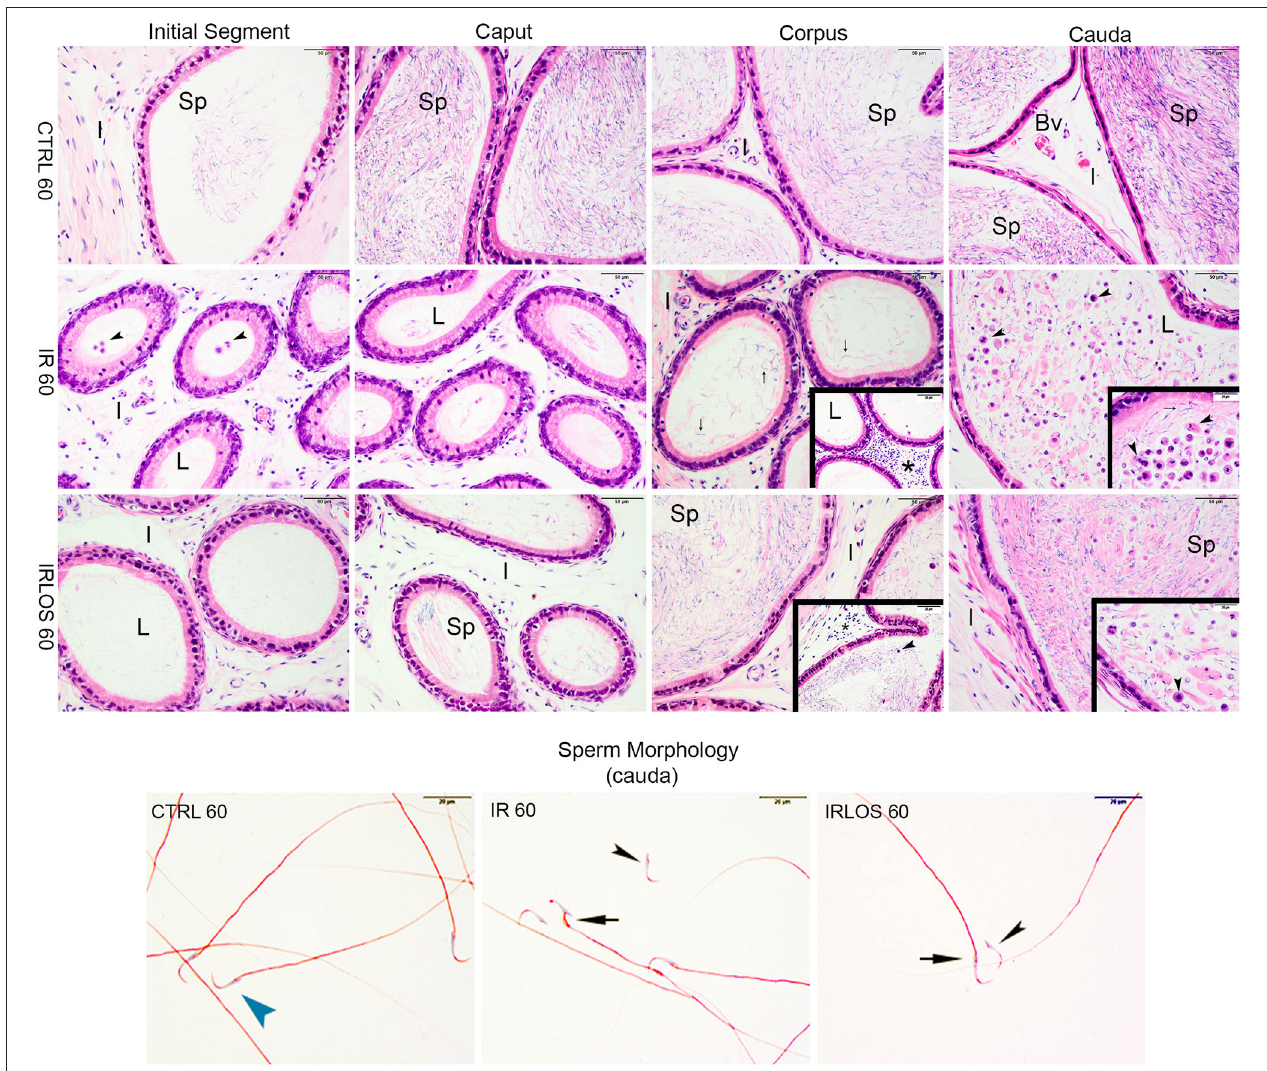
FIGURE 4 | Representative photomicrographs of epididymis and sperm morphology from control (CTRL 60), irradiated (IR 60), and irradiated and treated with losartan (IRLOS 60) groups after 60 days of exposure to the ionizing radiation. In the control group, the epididymis segments (initial segment, caput, corpus, and cauda) exhibited a normal morphology, with high intraluminal (L) sperm (sp) content. The irradiated group exhibits damage signal irradiation, characterized by a decrease of sperm content and extensive exfoliated germ cells and cells debris ( ◮ ) from the testes. Interstitial tissue (I) exhibited inflammatory infiltrates (*), being most frequently seen in the corpus. In the irradiated and treated group, losartan attenuated the damage to the epididymis. The interstitial tissue presented a slight inflammatory infiltrate. Reduced density of exfoliated germ cells and cell debris was observed, and normal forms of sperm into the lumen, although isolated sperm head and tail were still frequent. In irradiated groups, isolated sperm from cauda of epididymis exhibited abnormal morphology. Bv, blood vessels. ◮ sperm with normal morphology; ◮ , head defects; → , midpiece defects; scale bar, 50 µ m, insets, 20 µ m. Staining: Epididymis, hematoxylin and eosin; Sperm,